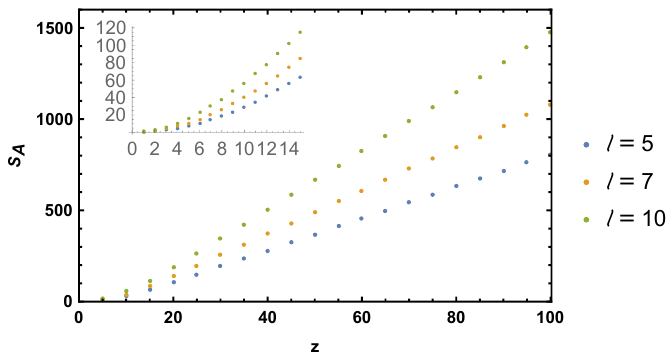
Figure 13 . EE as a function of z for square entangling regions with di(cid:11)erent size. The internal panel focuses on 1 < z < 15. We have set N x = N y = 250 and m = 0 with Dirichlet boundary